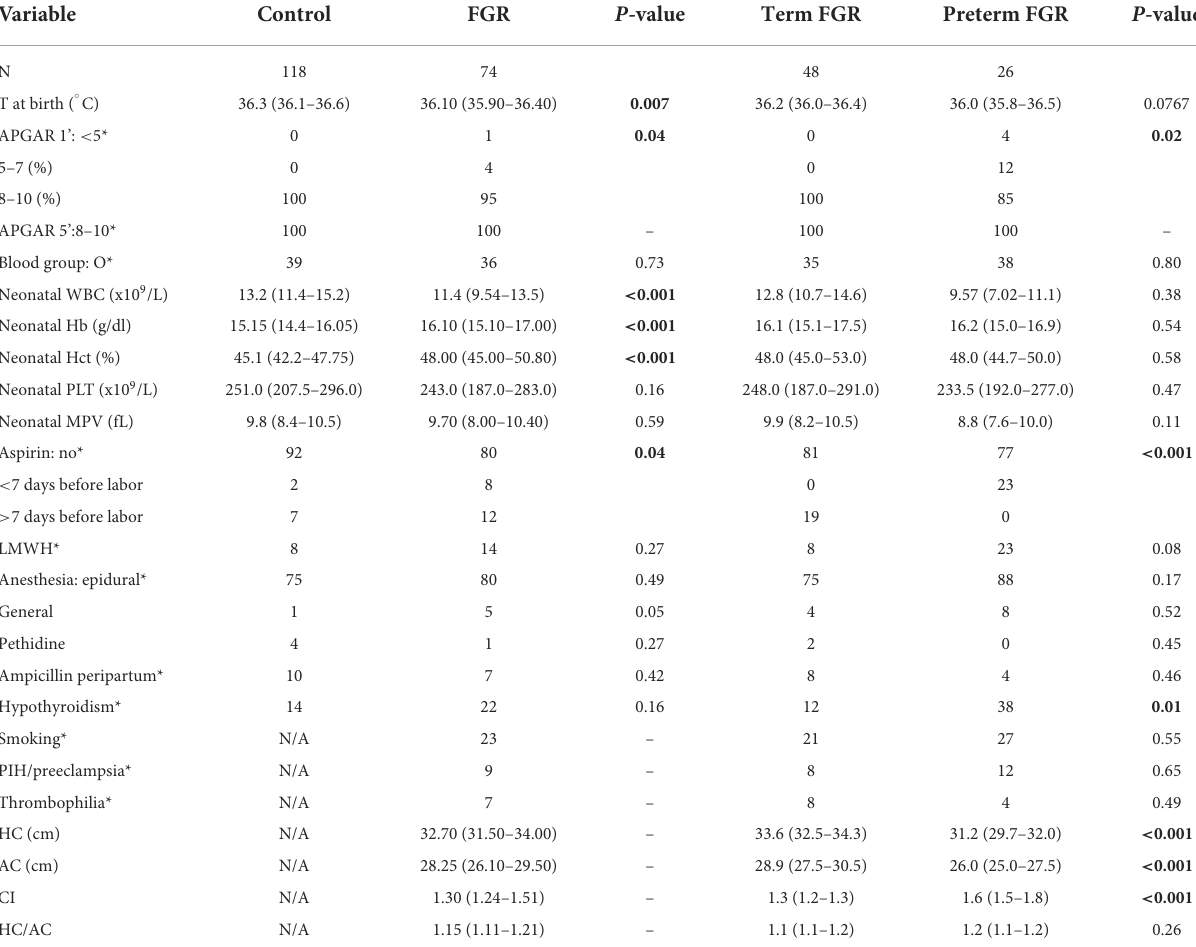
TABLE 2 Perinatal parameters of control, FGR, term FGR, and preterm FGR neonates.